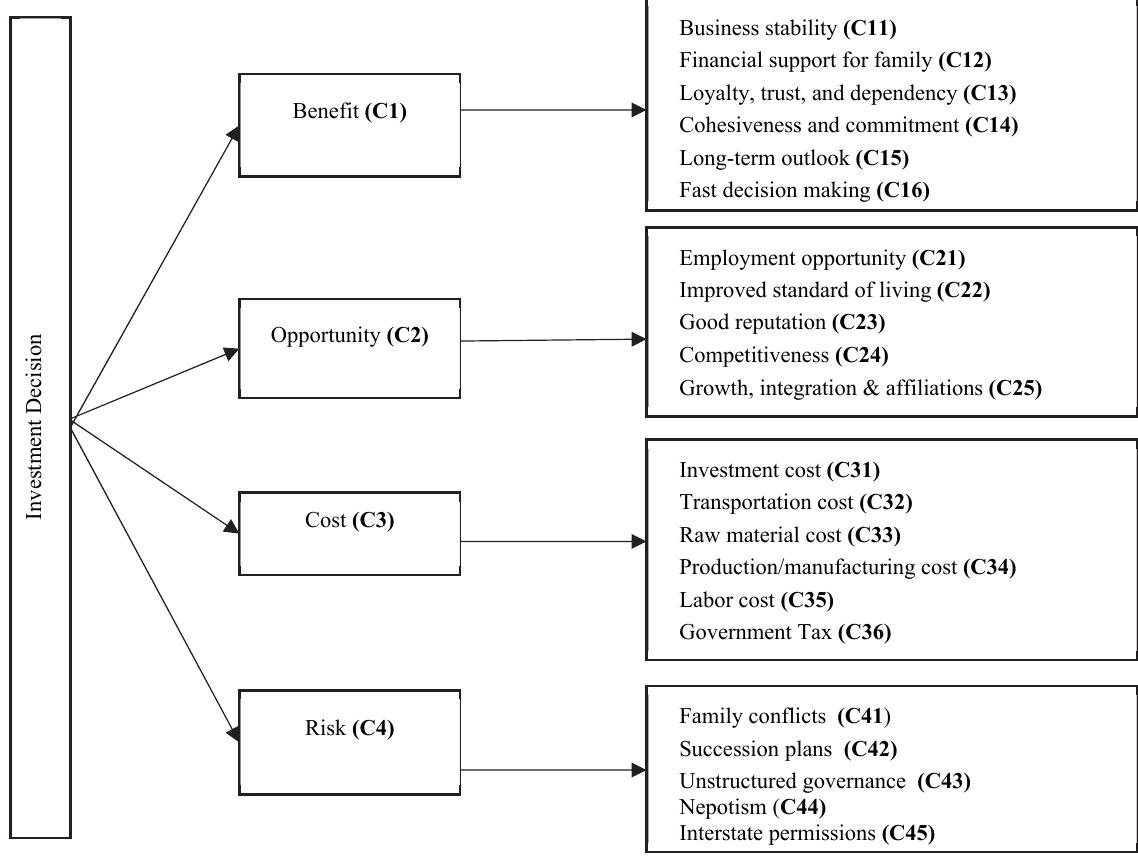
Fig. 1. Research Model of Multi-Criteria Decision